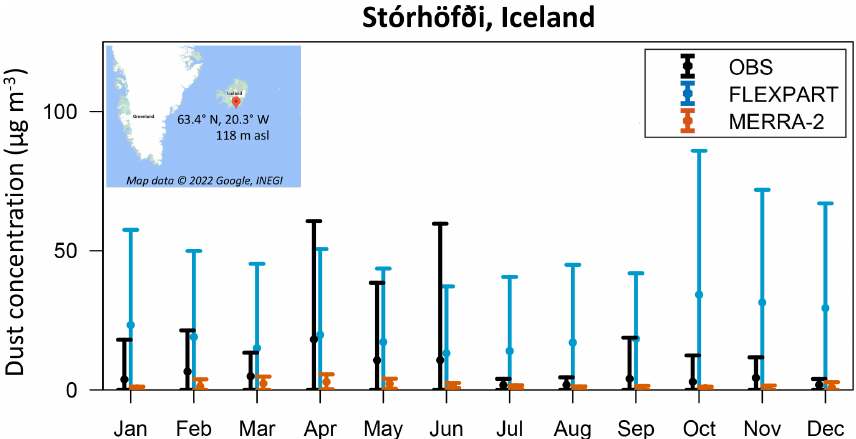
Figure 5. We compared long-term ground-based mineral dust observations at an Icelandic site with large local dust emissions (Stórhöfði, Heimaey) from Prospero et al. (2012) to dust concentrations during the 2008–2015 study period from MERRA-2 and FLEXPART. The whiskers show mean and standard deviation. MERRA-2 (brown) substantially underestimated observed mineral dust concentrations com- pared to observations (black), particularly in the spring when local emissions are highest. Adding local dust emission sources into MERRA-2 should improve the